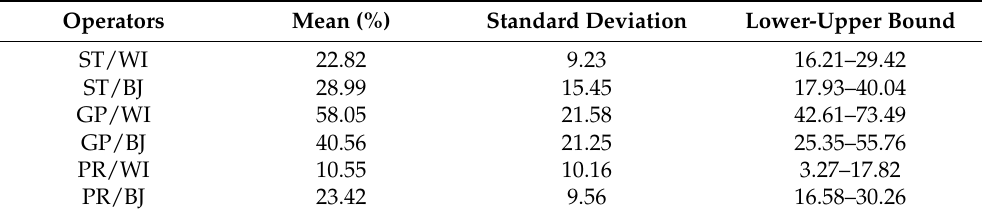
Table 1. Results in percentage of exposed dentin areas: mean, standard deviation, and lower-upper bound (95% confidence interval).